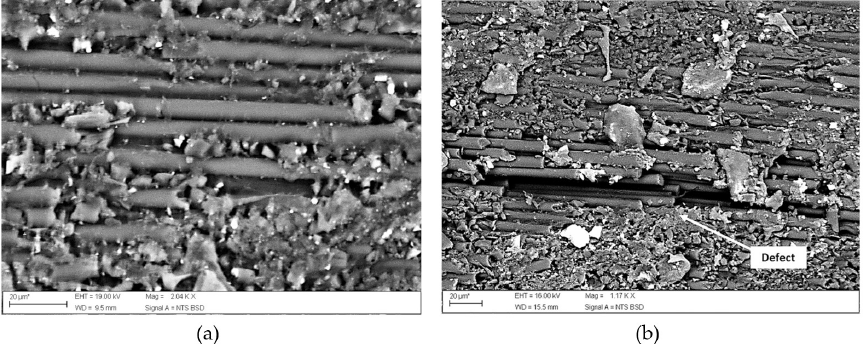
Figure 11. CF/PA6 laminates processed with pressure ( a ) of 0.3 MPa and ( b ) below 0.3 MPa. Adapted with permission from Reference [52].